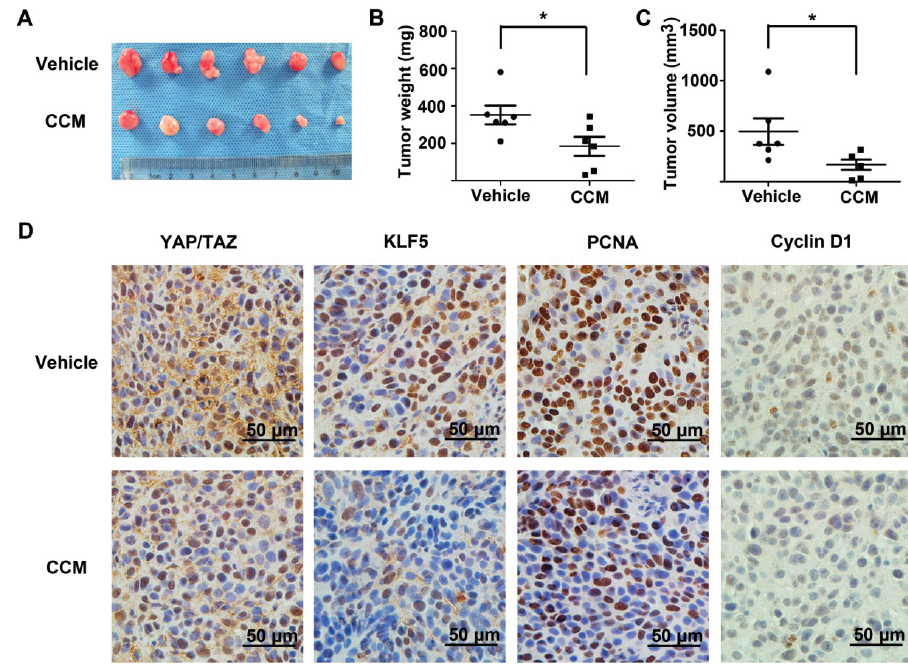
Figure 6. Antitumor effects of curcumin on 5637 xenografts in nude mice and the YAP/TAZ/KLF5/cyclin D1 axis in vivo . ( A ) Tumors from 5637 implanted nude mice, treated with vehicle or 200 mg/kg/day curcumin for three weeks; Tumor weight ( B ) and volume ( C ) were compared between the two groups; and ( D ) Representative photograph (400×) of immunohistochemistry (IHC) staining of YAP/TAZ, KLF5, PCNA and cyclin D1 expression in tumor sections from the vehicle and curcumin-treated xenografts. * p <